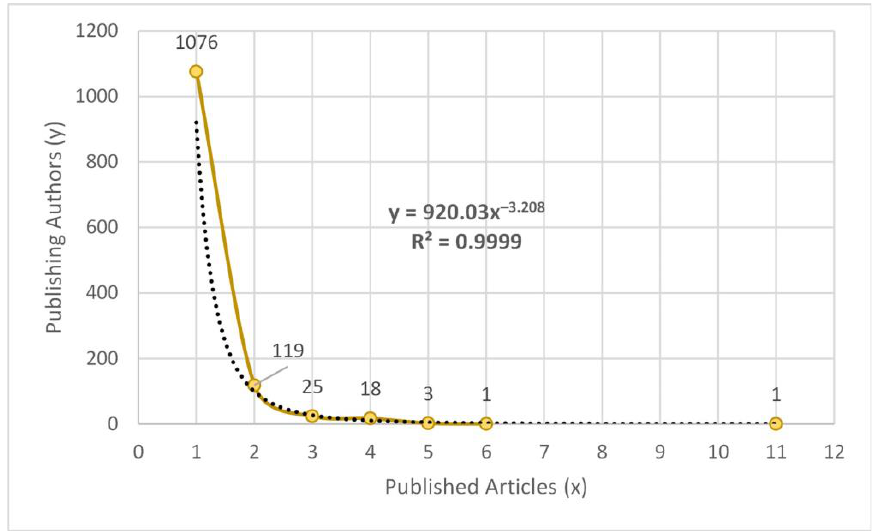
Figure 2. Relationship between scientific production level and authors.